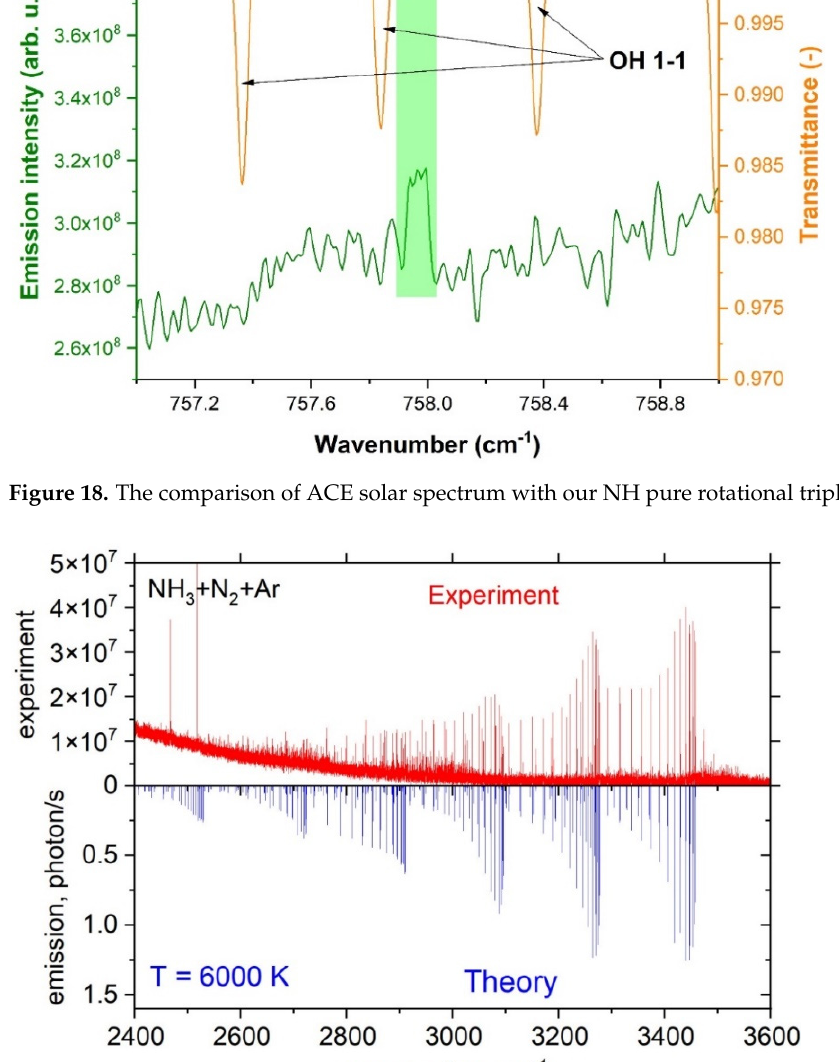
Molecules 2022 , 27 , x FOR PEER REVIEW 21 of 42